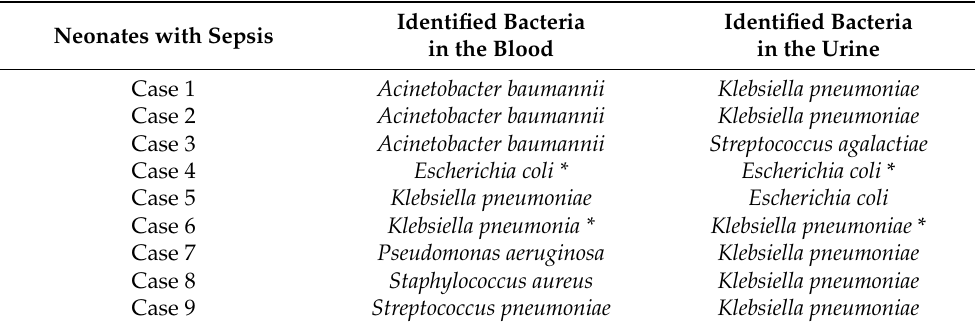
Table 1. Simultaneous infection/colonisation of identified bacterial isolates in blood and urine of neonatal intensive care unit (NICU) patients with positive blood cultures. Identified Bacteria Identified Bacteria Neonates with Sepsis in the Blood in the